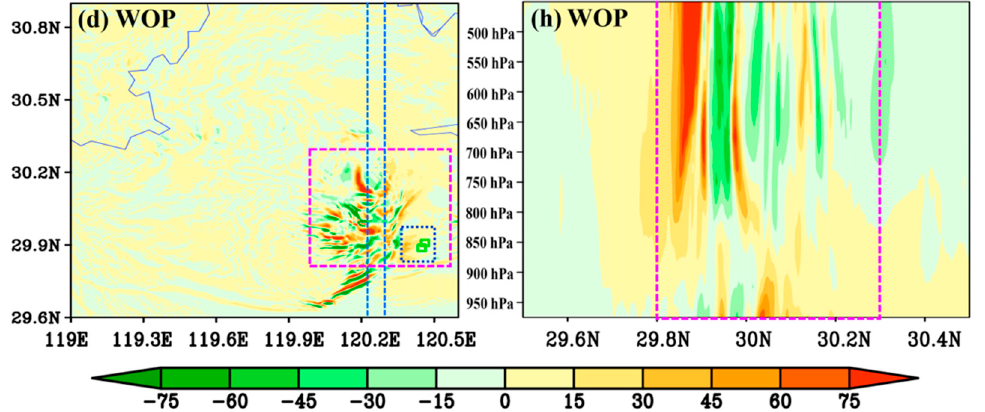
Figure 15. Panels ( a – d ) show the KE budget terms (shading; 10 − 2 W kg − 1 ) at 13:44:00 UTC 14 May 2021 (at the height of 500 m), where the purple dashed boxes show the key regions, the small green boxes mark the locations at which the tower toppling appeared, the blue dashed boxes show the region surrounding the tower toppling locations, and the two dashed blue lines mark the band (from 120.24° E to 120.32° E) for calculating the averaged cross section. Panels ( e – h ) show the averaged (from 120.24° E to 120.32° E) cross section of the KE budget terms (shading; 10 − 2 W kg − 1 ) at 13:44:00 UTC 14 May 2021, where the purple dashed lines mark the key region.